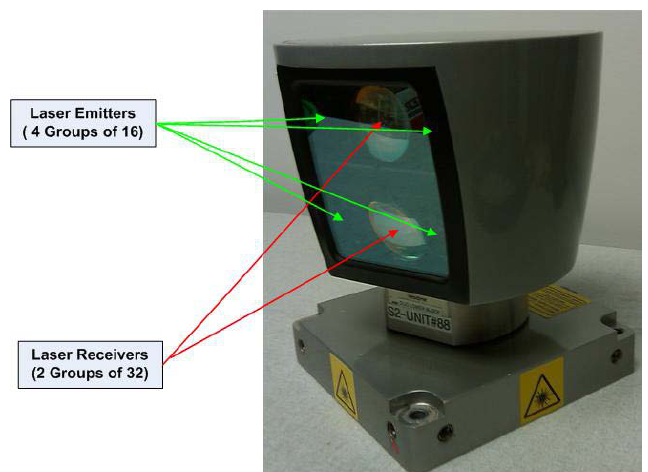
Figure 1. The Velodyne HDL-64E S2